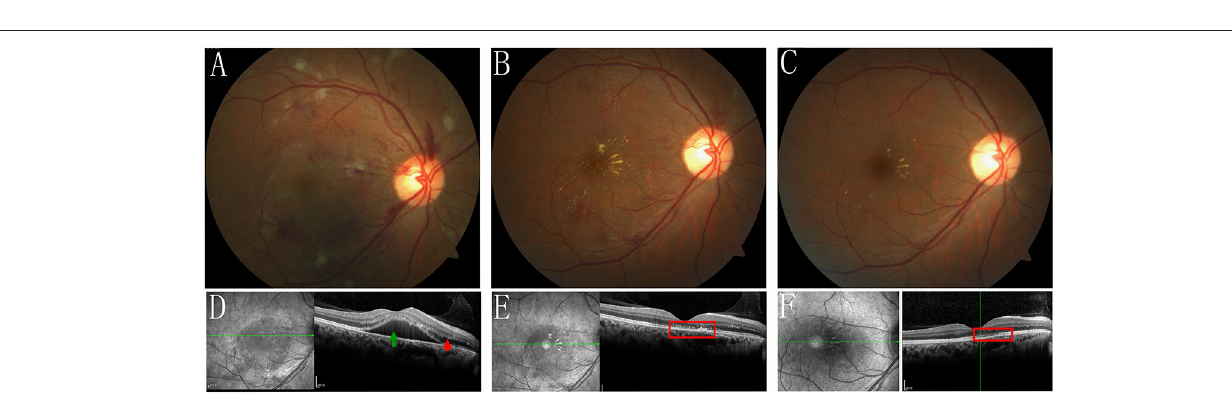
deposition of subretinal fibrin after the absorption of subretinal effusion in the remission stage. The interrupted and disorganized RPE revealed that part of the RPE function was already irreversible in the right eye. This documented the severity of the breakdown of the external